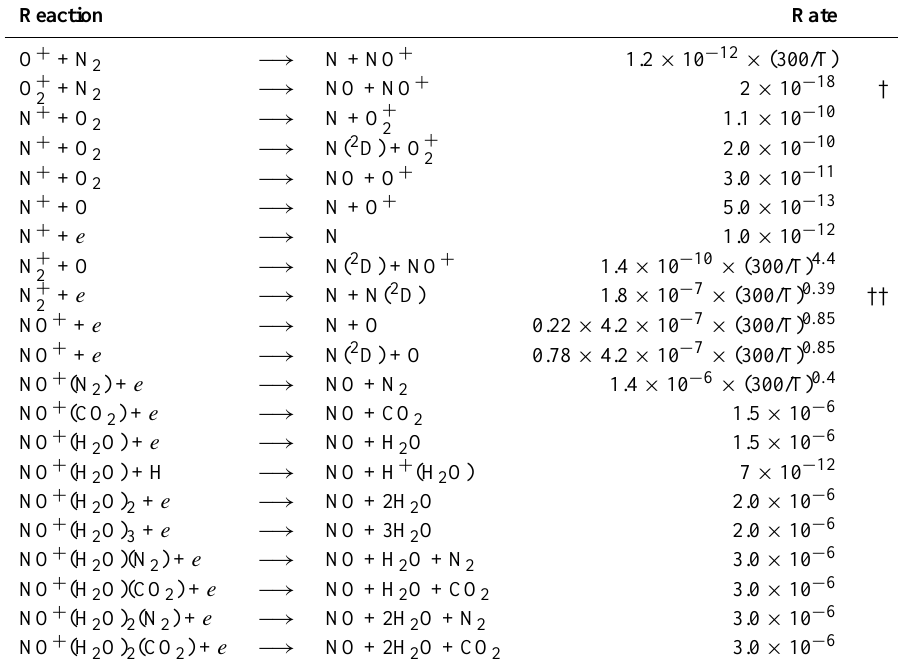
Table 7. The ionic reactions producing odd nitrogen. The sources of the reaction rates are listed by Turunen et al. (1996), except for † and †† which are taken from Matsuoka et al. (1981) and Rees (1989), respectively